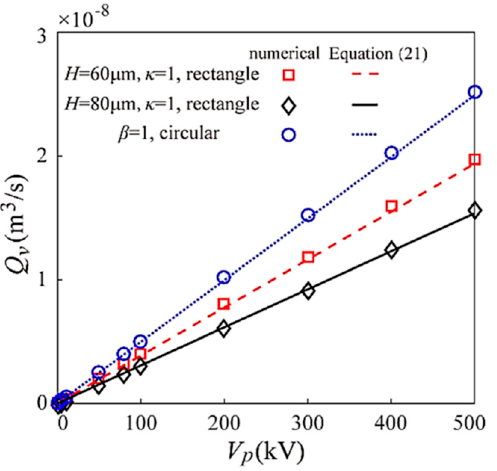
Figure 4. Effect of applied voltage on the flowrate of EOF in the Y-shaped microchannels with different geometries and configurations.